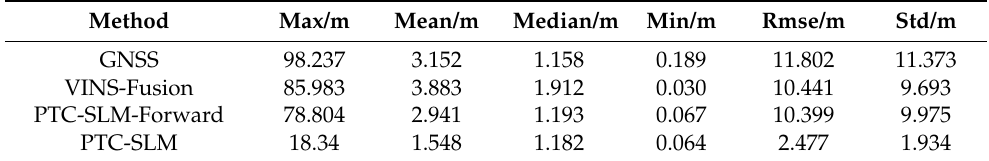
Table 8. Error parameters of the four methods in urban